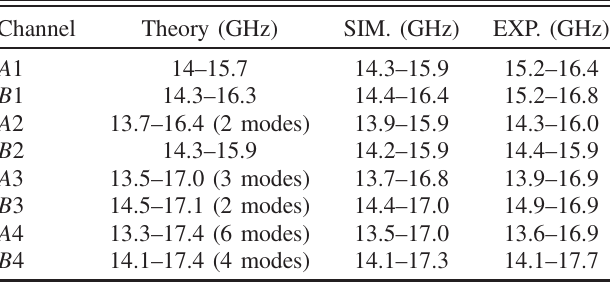
TABLE I. The bandwidth of the waveguide array. In theory, when several waveguide modes overlap in frequency, the band- width is the union of the frequencies of these modes.